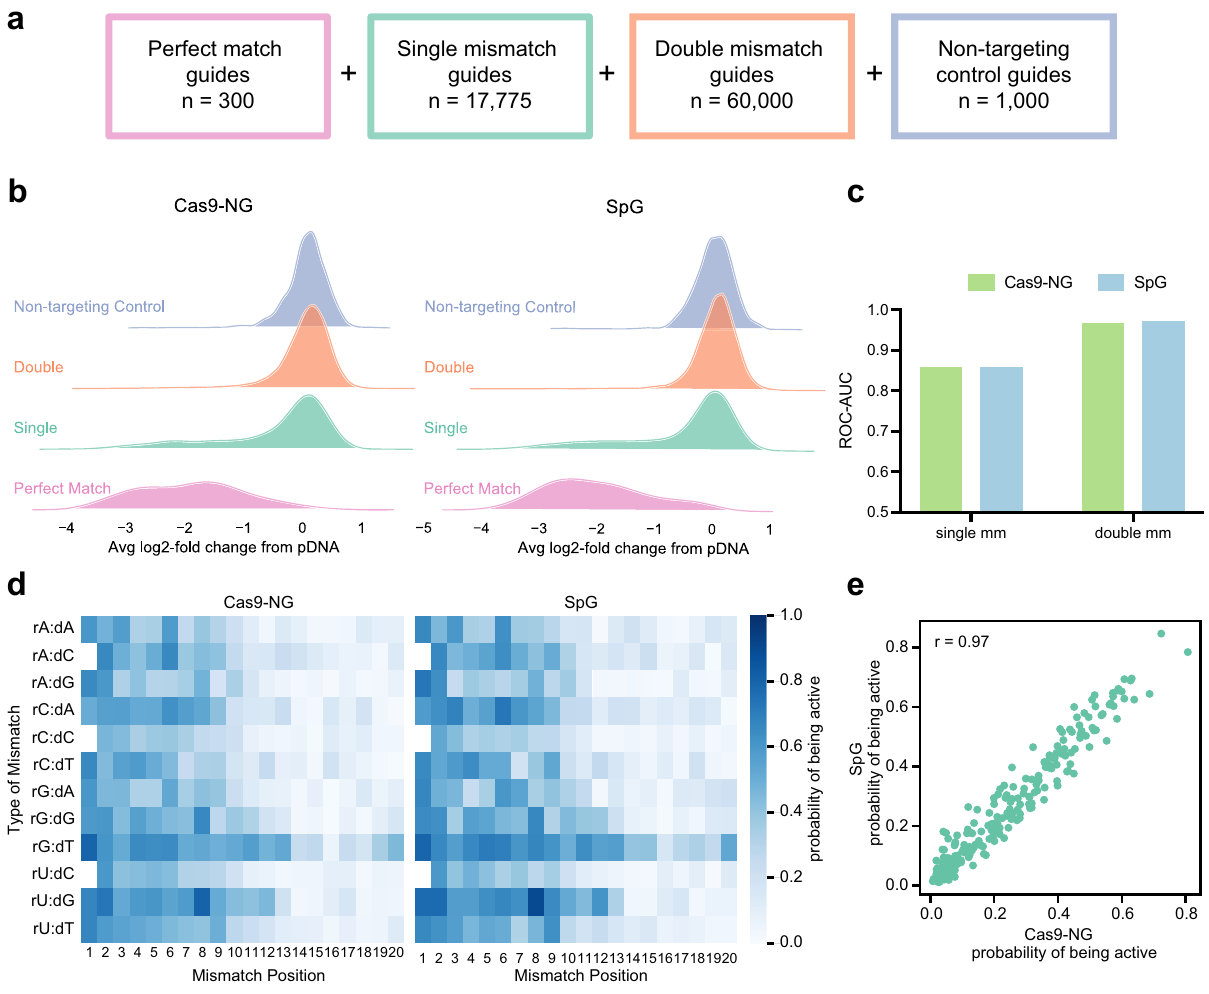
Fig. 4 Off-target pro fi les of Cas9-NG and SpG. a Schematic depicting off-target library construction and guide selection. b Ridge plots showing activity of fi ltered guides with zero, one or two mismatches. c ROC-AUC values at single and double mismatches for Cas9-NG and SpG. d CFD matrix for Cas9-NG and SpG. Note that there are no wildtype g20 and G20 guides with a G in the fi rst position, so the rN:dC squares are blank. e Scatter plot showing probability of being active for each single mismatch position/type for Cas9-NG and SpG ( n = 237). Pearson correlation is noted in the top left. Source data are provided as a Source Data fi